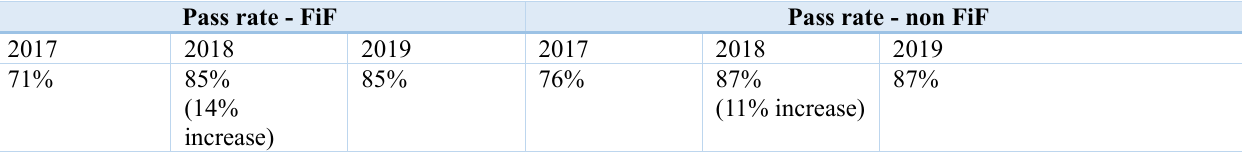
Comparison of Pass Rates Between Low, Medium and High SES Students Pass rate – Low SES